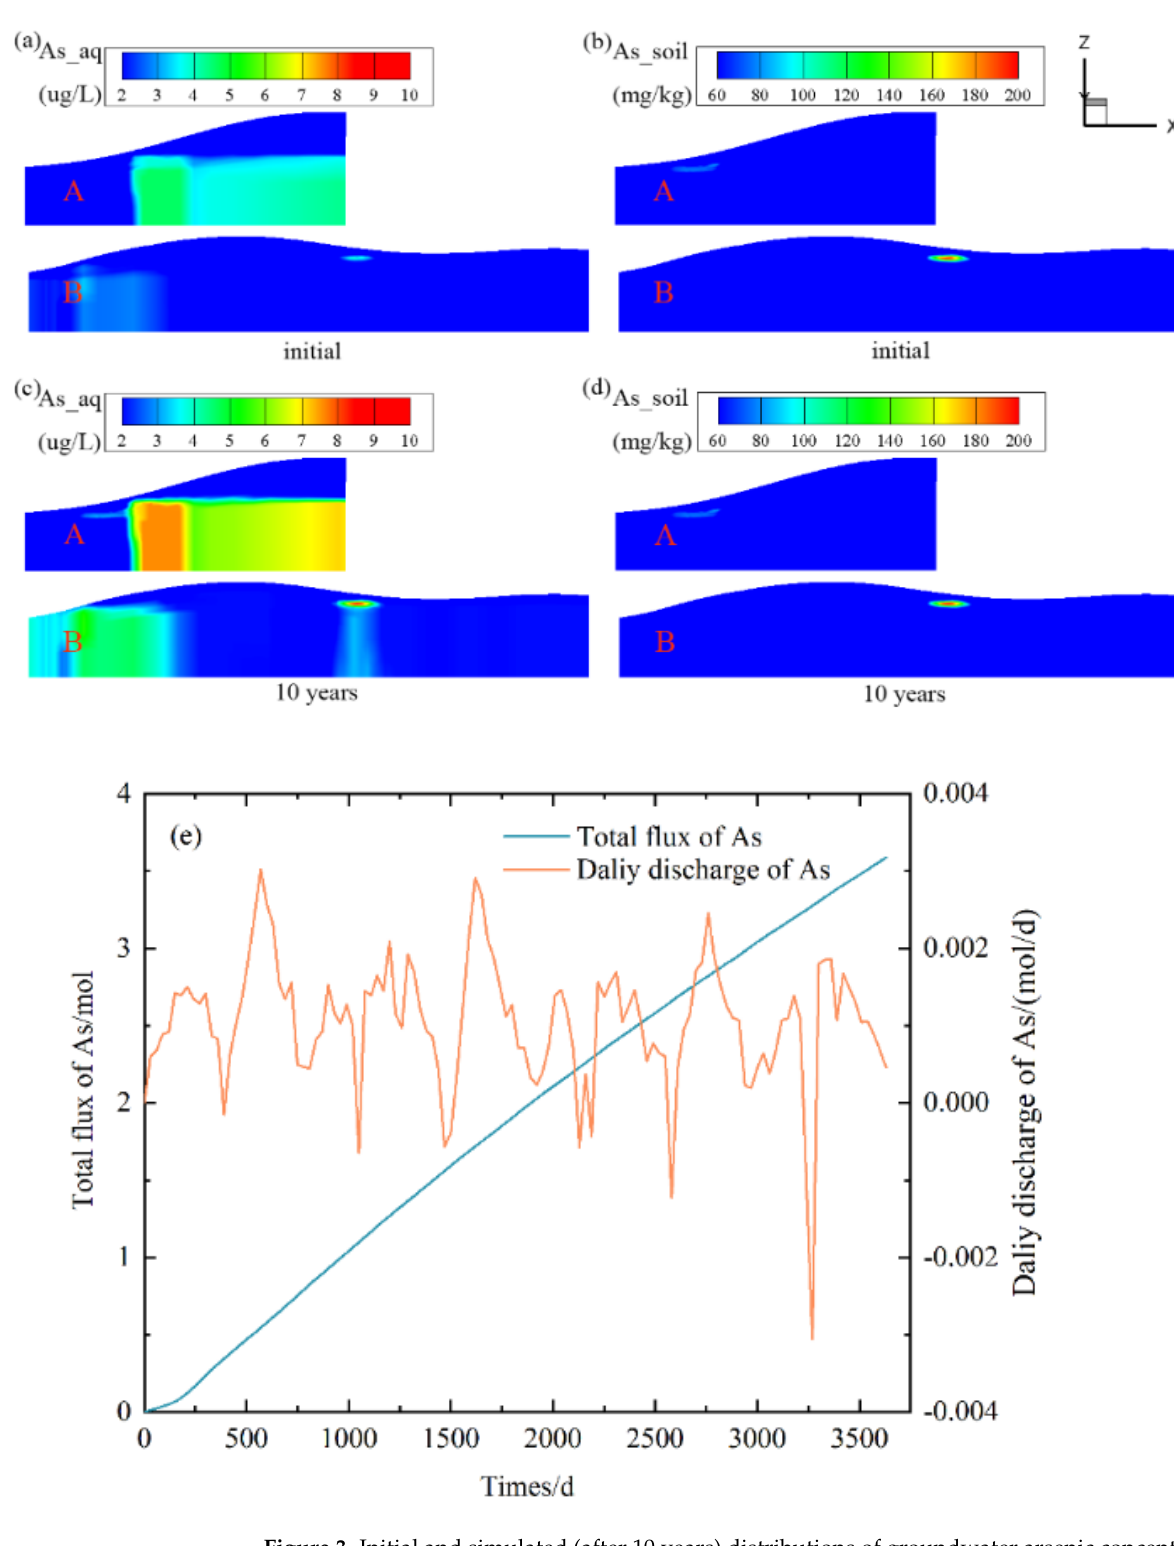
Figure 3. Initial and simulated (after 10 years) distributions of groundwater arsenic concentrations ( a , c ) and soil arsenic concentrations ( b , d ) along cross-sections A and B without any soil treatments. Here, As_aq and As_soil represented groundwater arsenic concentration, soil arsenic concentration, respectively. The locations of cross-sections A and B were provided in Figure 2. Plot ( e ) is the total flux and daily discharge of As from the site to the river.